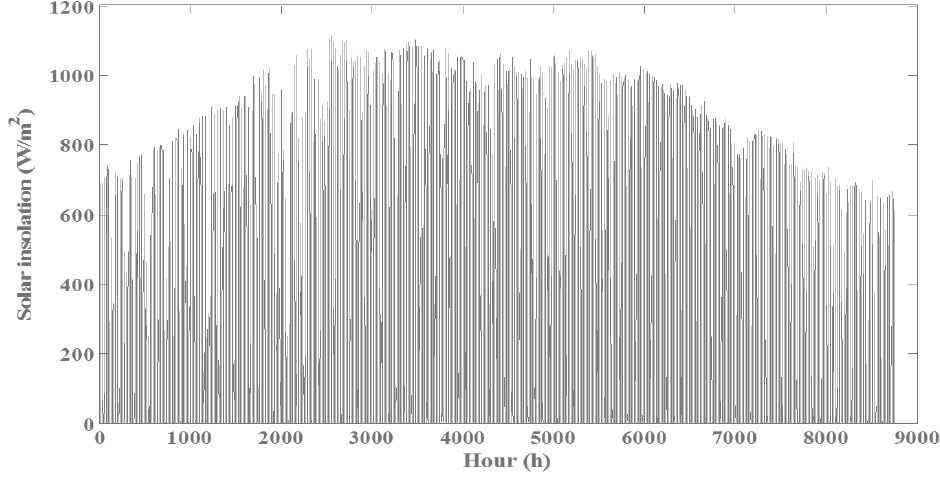
Figure 3. The Shape of the Intensity of the Sun's Radiation in the Target Area throughout the Year.